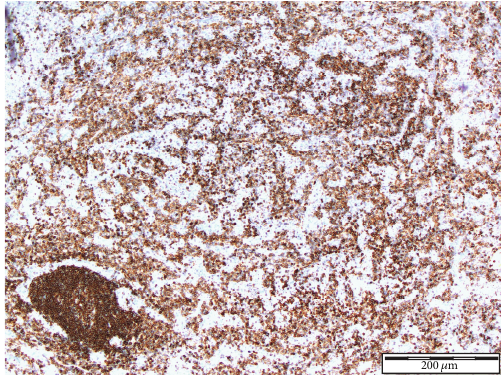
Figure 5: Immunohistochemical staining for LCA × 4 magnifica- tion. The background dense lymphoid infiltrate showing positive hmj.v6i3.245) with permission from Hamdan Medical Journal